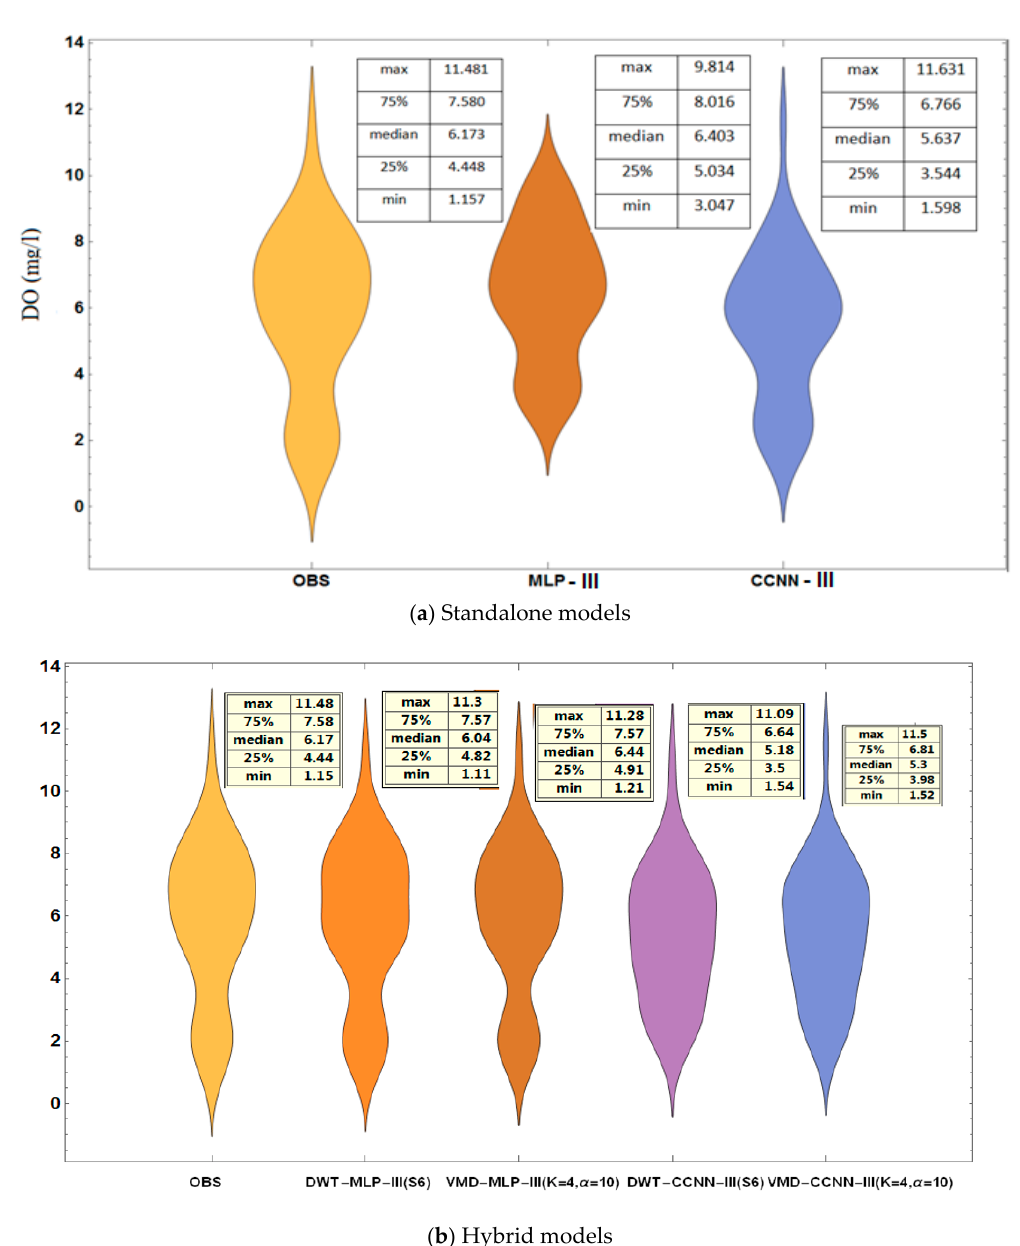
Figure 14. Violin plots of observed and predicted DO concentration.